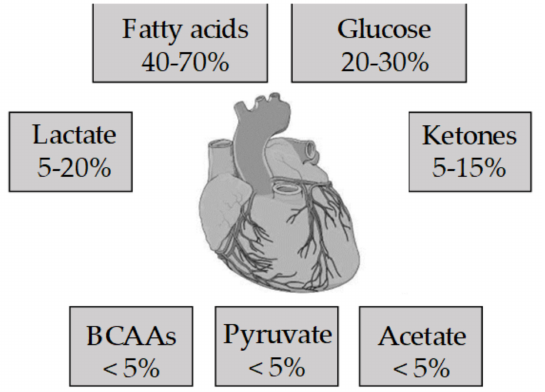
Figure 1. Metabolic substrate used by the healthy heart. BCAAs, branched-chain amino